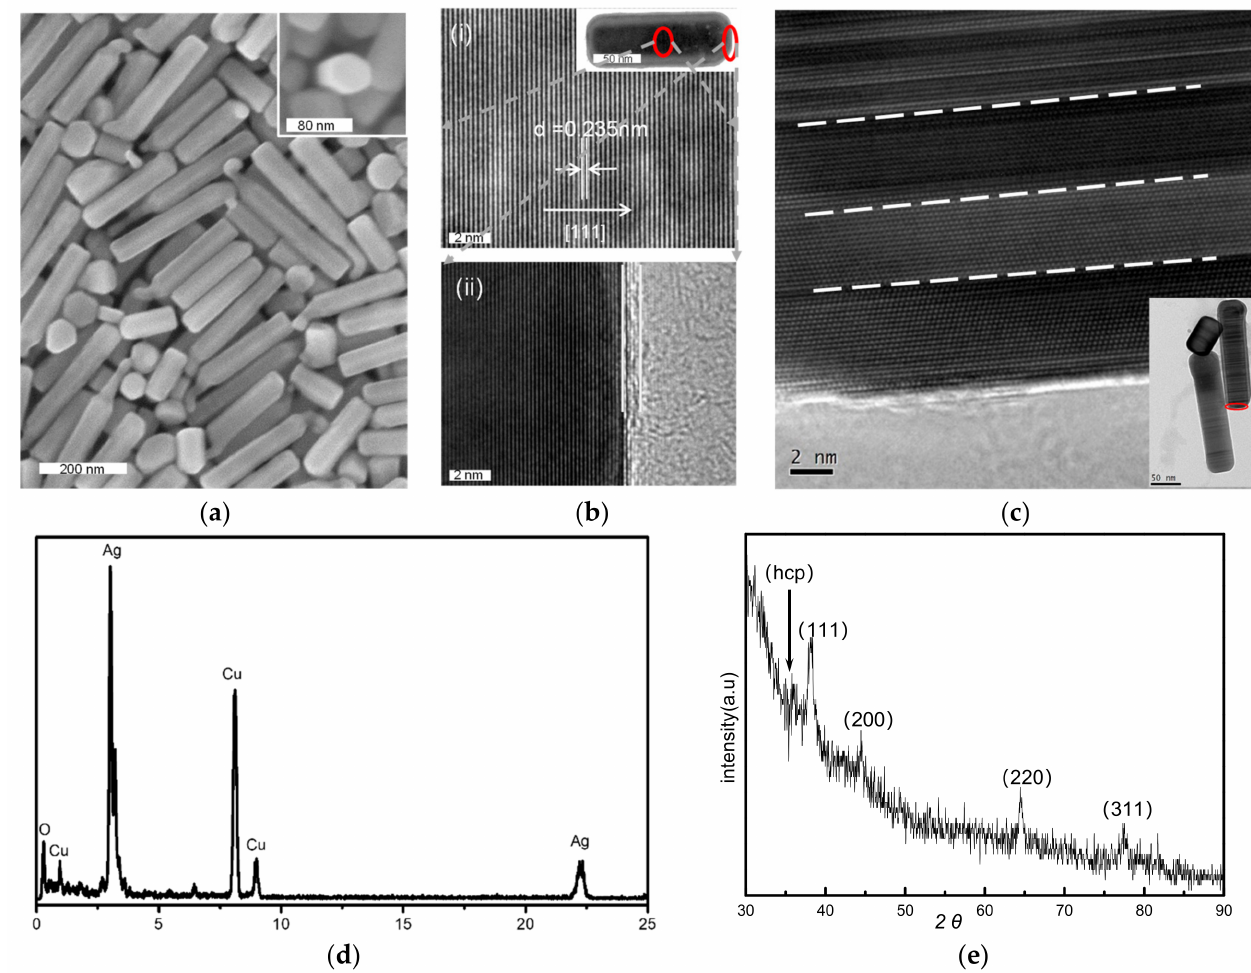
Figure 1. ( a ) The scanning electron microscopy (SEM) image of silver nanopillars (SNPs) synthesized from silver nanoparticles in 1 h, with candle-like structures and other by-products; inset shows the hexagonal cross-section of a nanopillar. ( b ) ( i ) The high-resolution transmission electron microscopy (HRTEM) image showing the lattice fringes of the SNP in the inset; ( ii ) The HRTEM image of the amorphous epitaxial layer on the side of SNP in the inset. ( c ) The HRTEM image of the nanopillar in the inset, revealing the lattice fringes and dislocations between layers at the one nanopillar’s side. ( d ) The energy-dispersive spectrum (EDS) spectrum of SNPs. ( e ) The X-ray diffraction (XRD) pattern of SNPs containing four peaks consistent with face-centered cubic (fcc) silver crystal